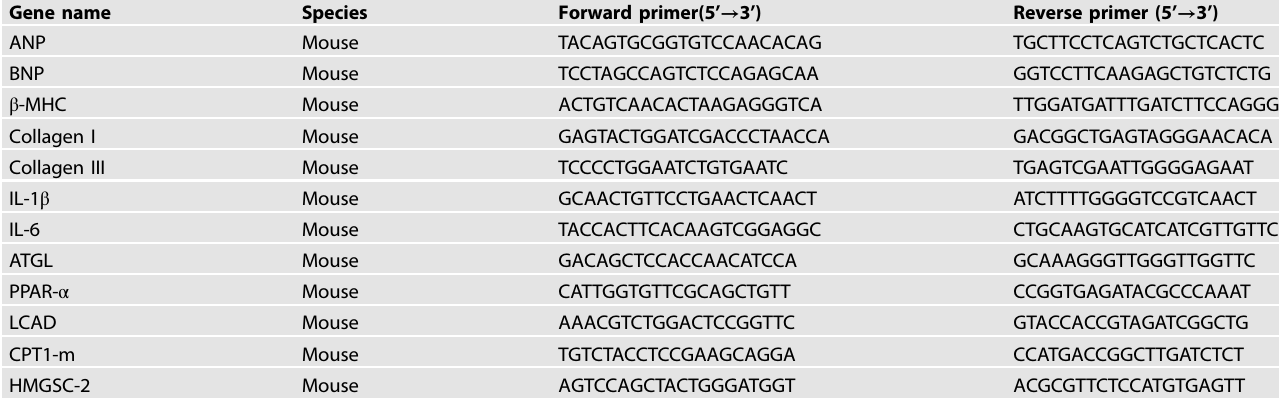
Table 1. Sequences of RT-PCR